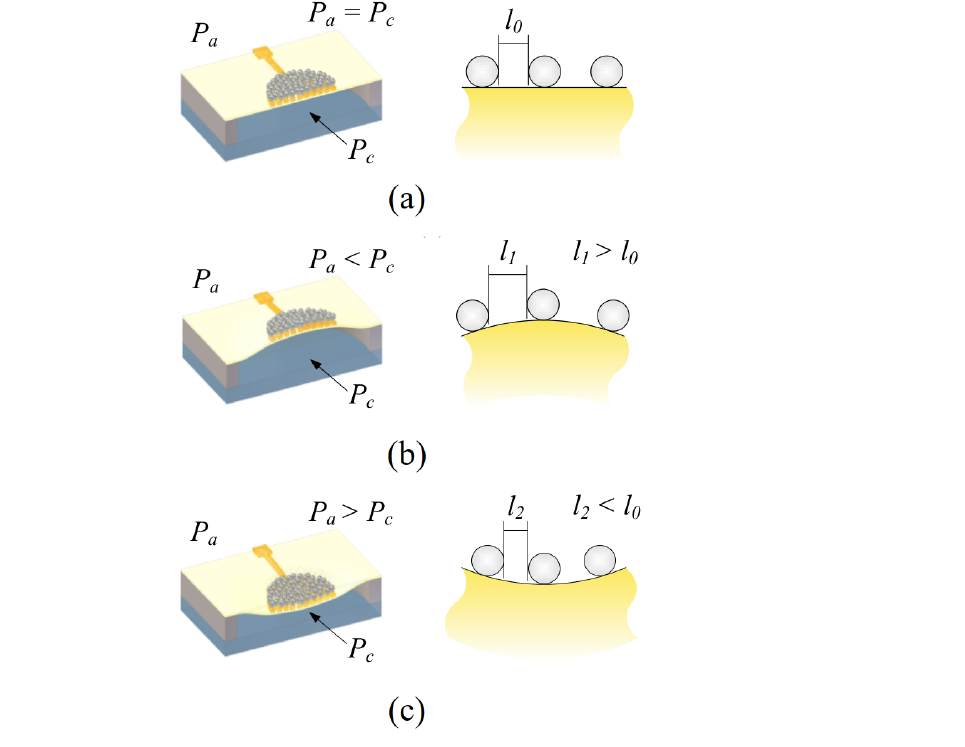
Figure 2. The device operational principle for three different conditions: ( a ) P a = P c , ( b ) P a < P c , and ( c ) P a > P c .